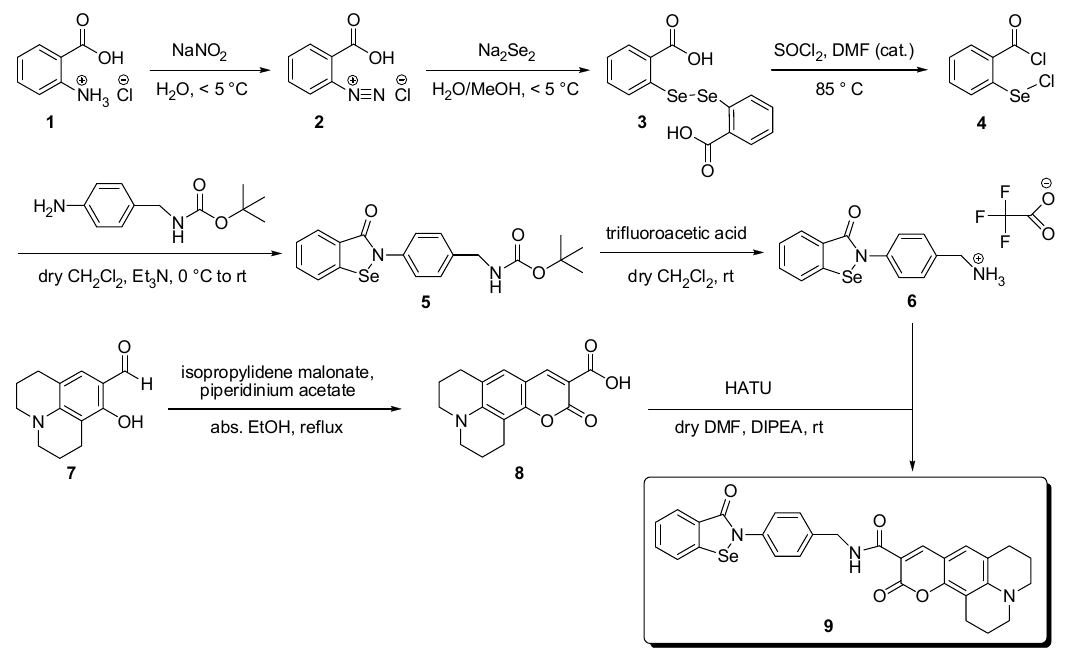
Scheme 1. Synthetic route to the coumarin-labeled ebselen derivative 9 .